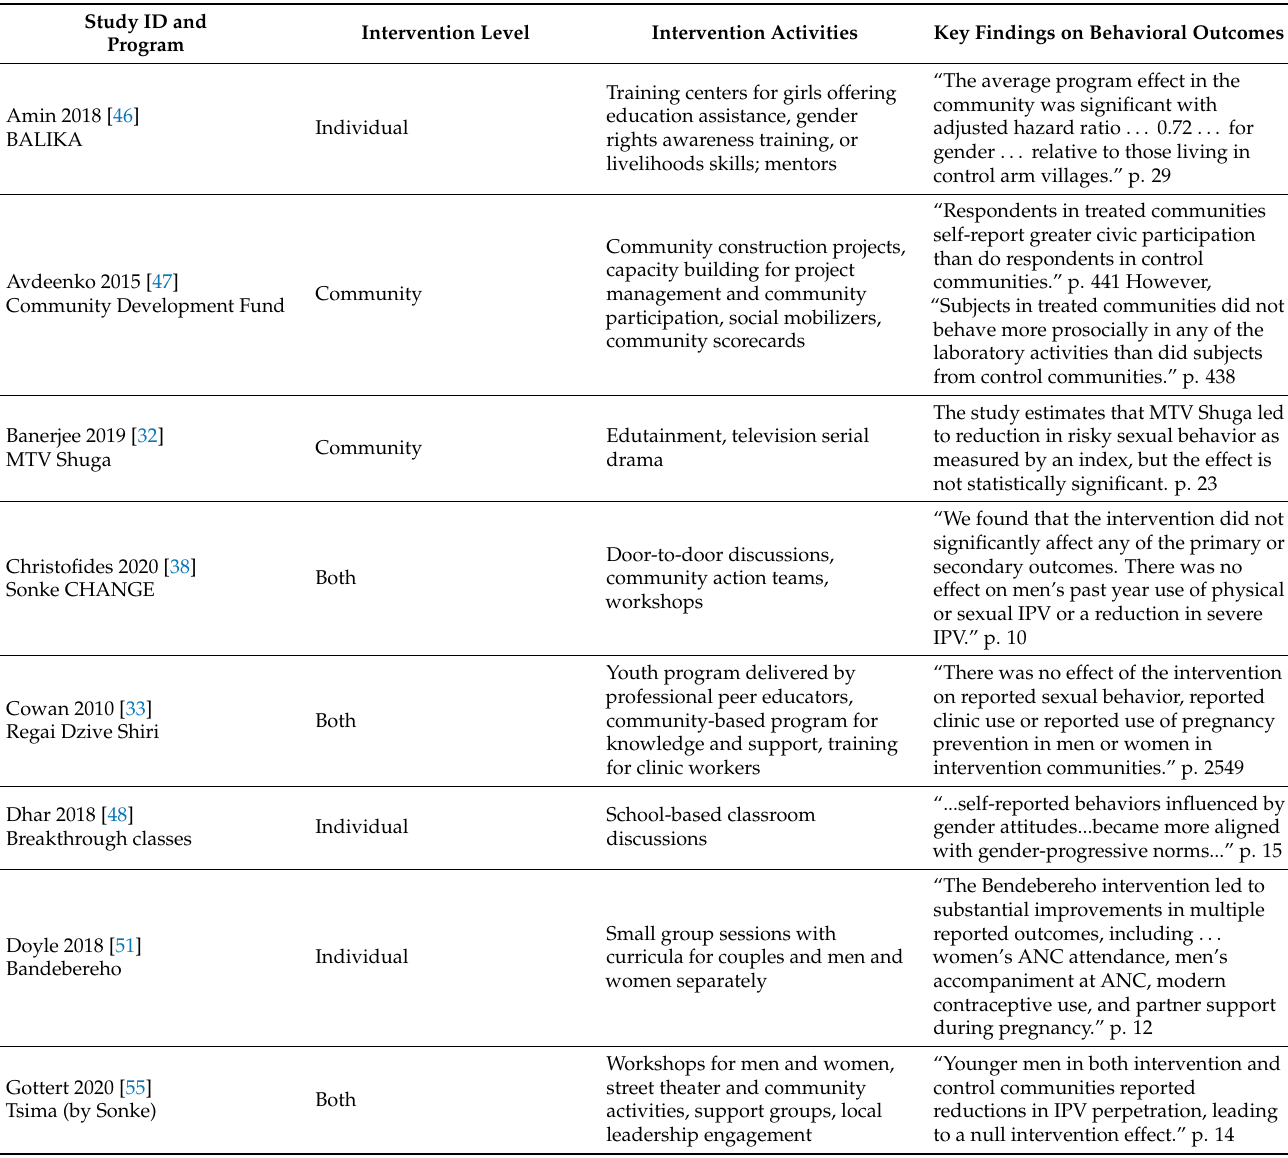
Table 3. Main findings for behavioral outcomes from primary studies assessed as having strong confidence in the